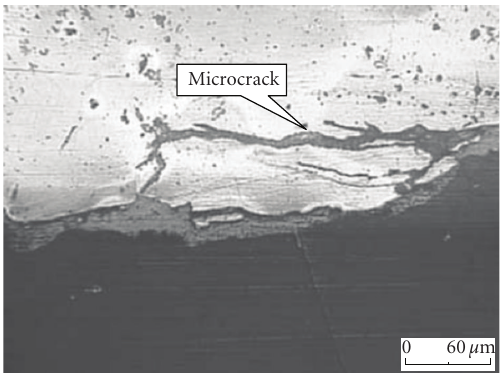
Figure 8: Optical metallograph of vertical section after impact- corrosion wear for 8 hours and 16 hours at the impact energy of